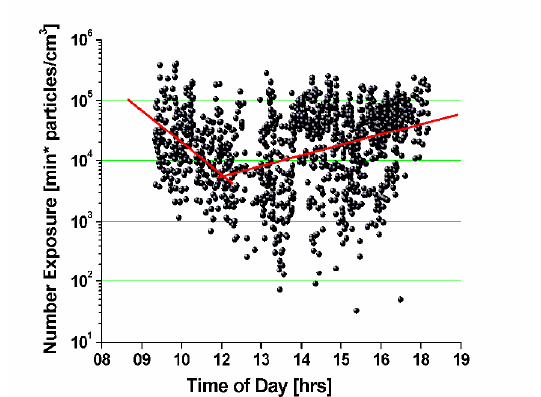
Figure 3 : This 7-working day summary shows an increase of particle number exposure during the early peak hours in the mornings, a depression during midday hours and an increase in the late afternoon. The superimposed trend lines group together the morning measurements and the afternoon measurements, which are separated by the background measurement performed at noon